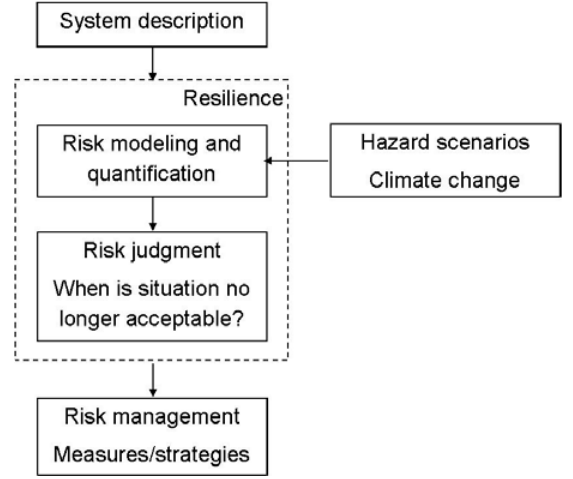
Figure 1. Risk assessment